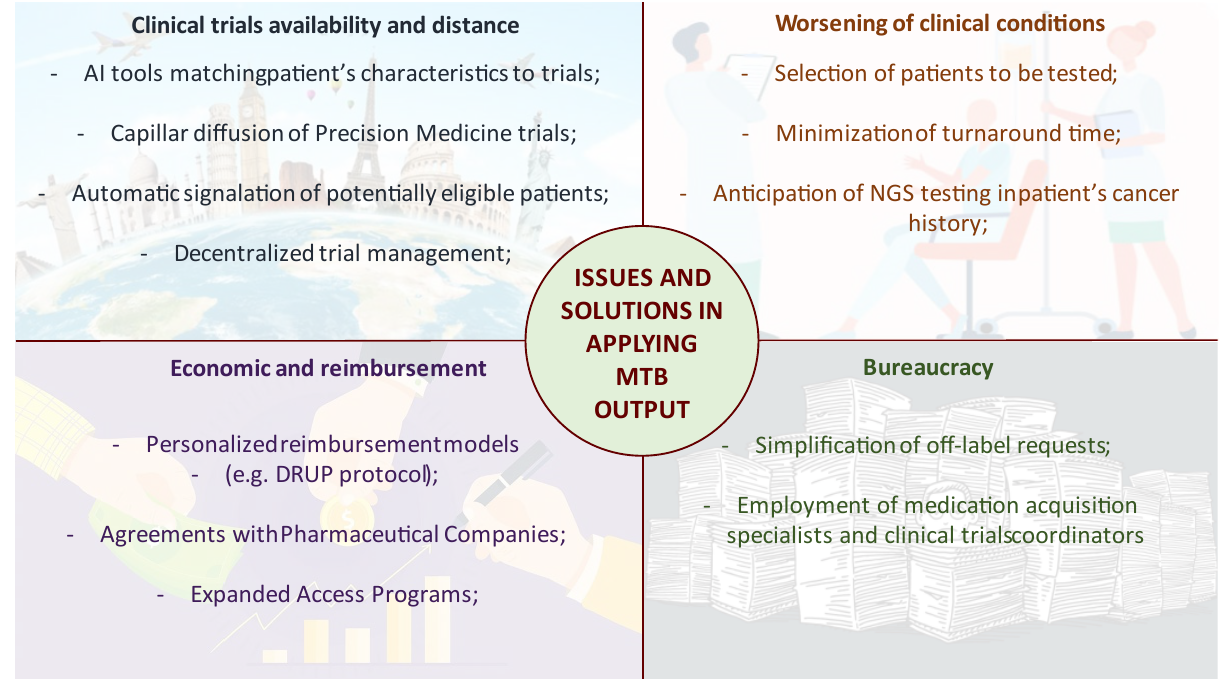
Figure 1. Schematization of the most frequent causes of MTB indication inapplicability and the proposed solutions.